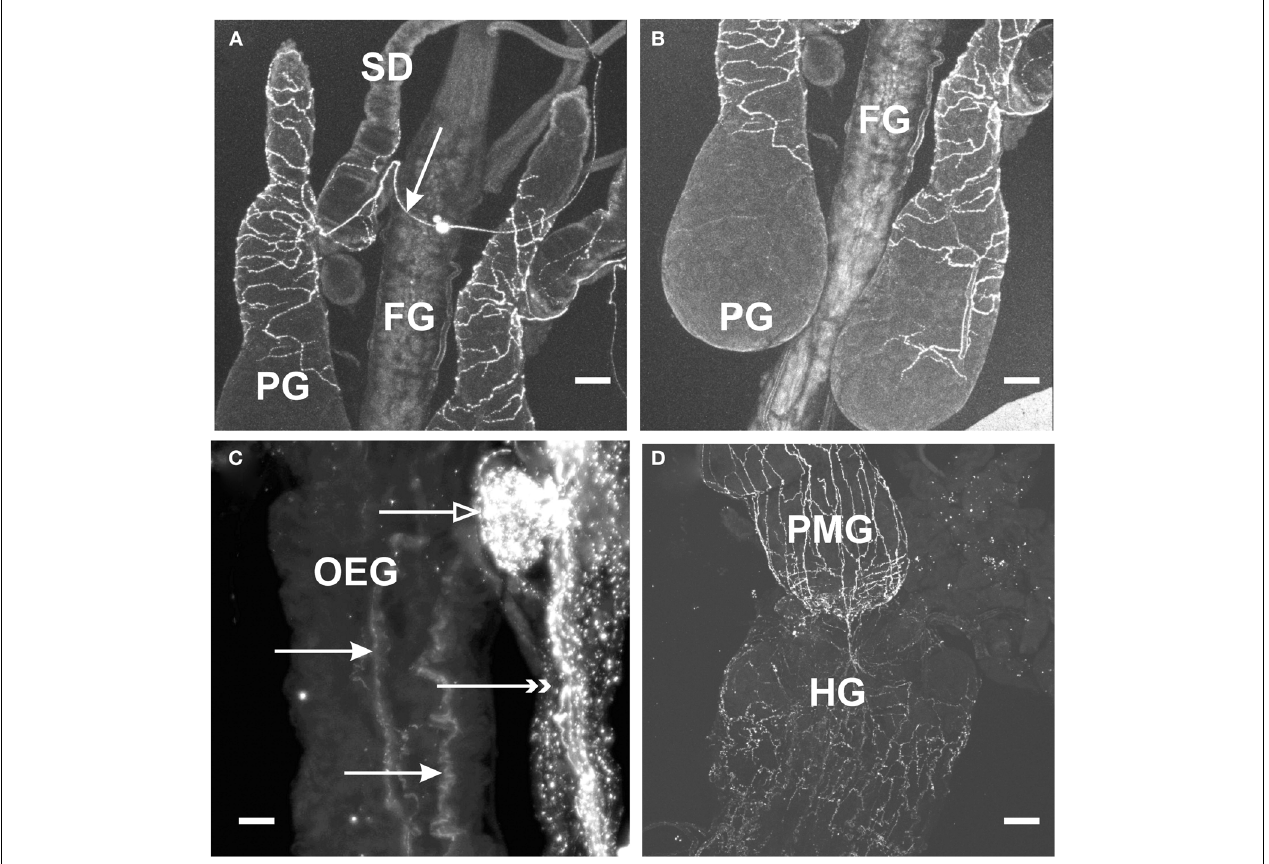
immunoreactive processes are seen on the esophagus (closed arrows) as well as processes on the dorsal vessel (double arrowheads) and covering the corpora allata (open arrow). (D) MIP-like immunoreactive processes extend from the hindgut (HG) onto the posterior midgut (PMG). Scale bars: (A,B,D) , 100 µ m; (C) , 25 µ